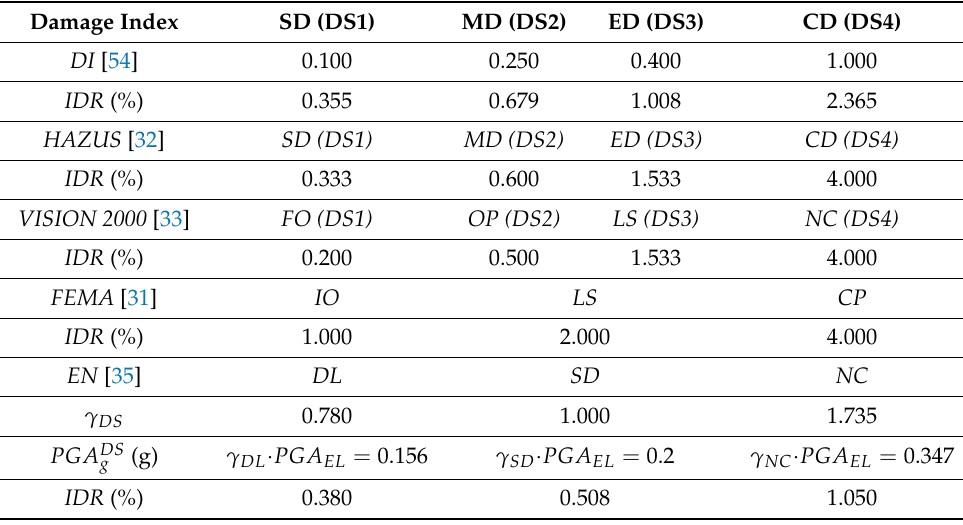
Table 2. Structural damage state threshold values.